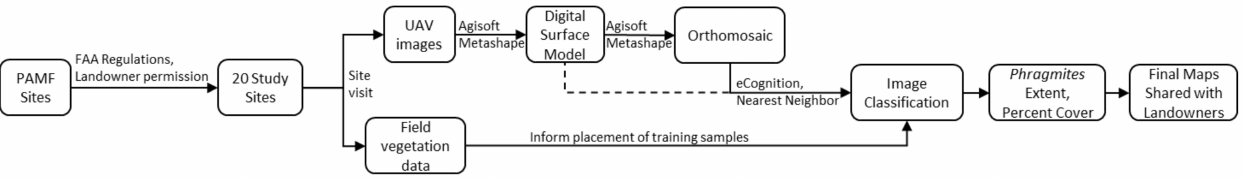
Figure 2. Flowchart of study methods.